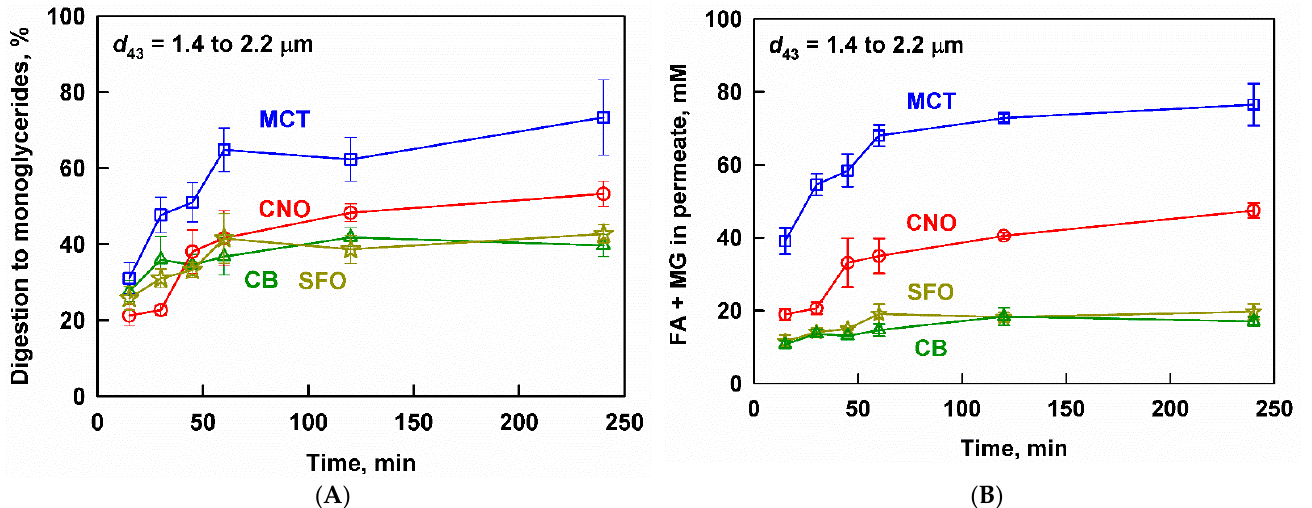
Figure 2. ( A ) Extent of lipid digestion to monoglycerides and ( B ) fatty acids (FA) and monoglycerides (MG) measured in the aqueous phase after filtration, as a function of the digestion time at simulated intestinal conditions of MCT (blue squares), CNO (red circles), SFO (yellow stars) and CB (green triangles) emulsions ( d 43 between 1.4 and 2.2 µm). Emulsifier concentration = 1 wt% for all emulsions.